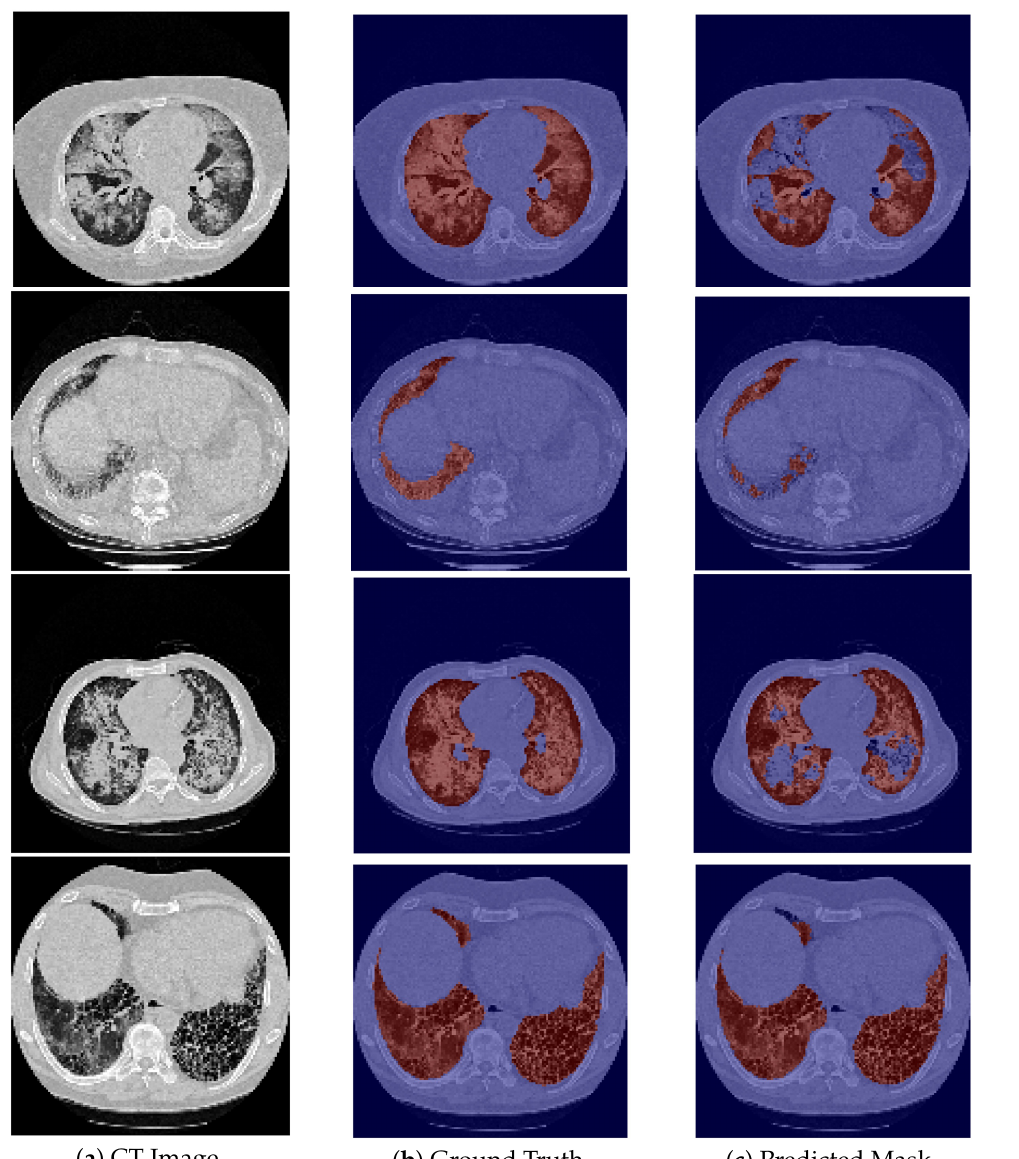
Figure 6. Examples from HUG-ILD dataset. First three rows show cases with higher density that the model does not classify as being lung tissue. Last row shows a darker pulmonary region misclassified by the